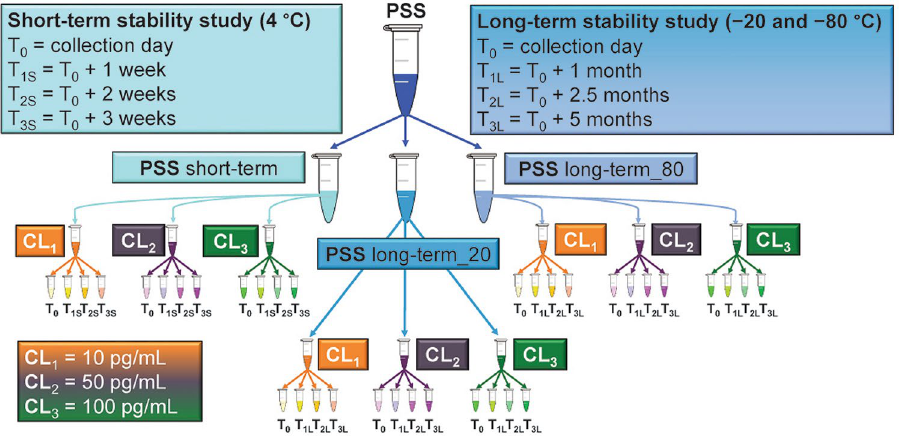
Figure 3. The structure of the stability studies carried out by storing saliva samples containing three different NT-proBNP concentrations (10, 50, and 100 pg/mL) at different temperatures (4, − 20, and − 80 °C). The short- term stability study investigated sample stability stored at 4 °C for up to 3 weeks, whereas the long-time stability investigated sample storage at two temperatures (− 20 and − 80 °C) for up to 5 months. Samples intended for freeze–thawing effect investigations are not